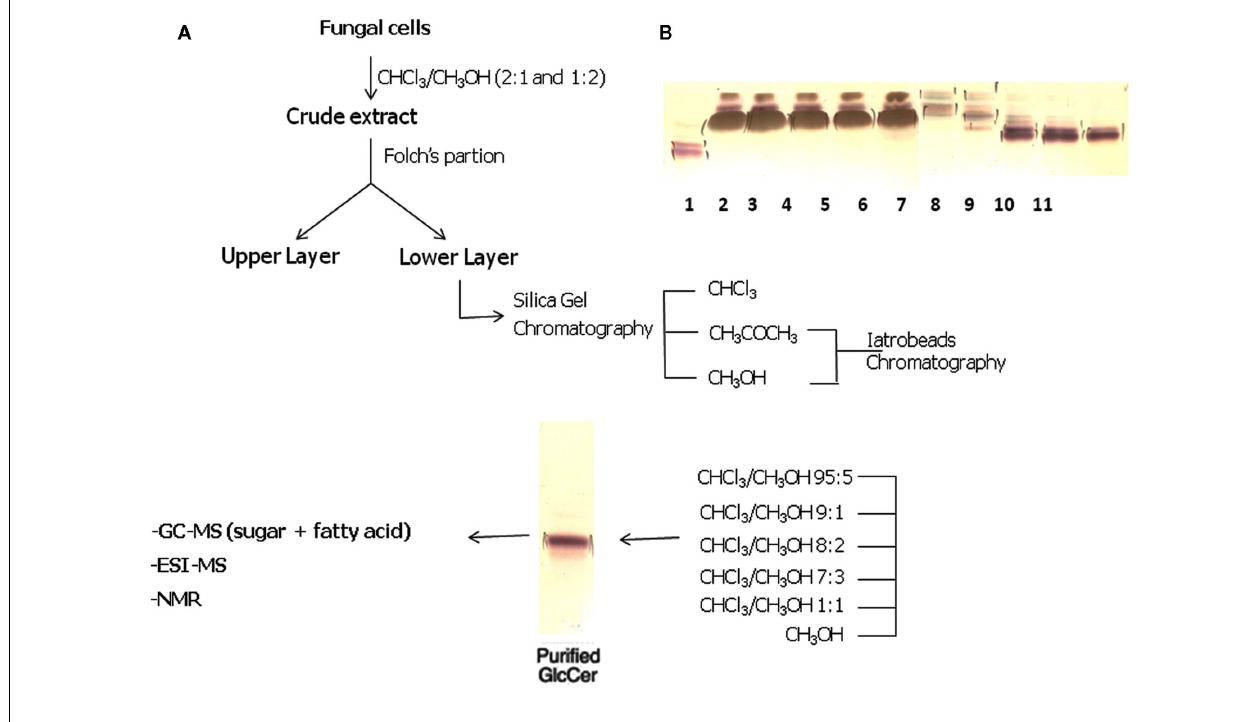
fractions. Lanes 7–8: Chloroform–methanol (90:10v/v) fractions. Lanes 9–11: Chloroform–methanol (80:20v/v) fractions. Solvent